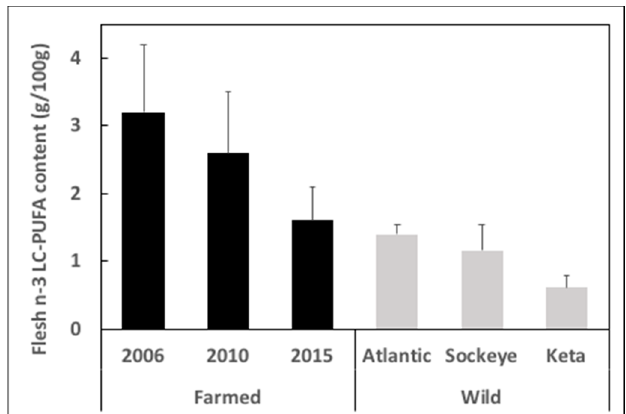
Figure 2. Content of n-3 long-chain polyunsaturated fatty acids (LC-PUFA) in flesh of Scottish farmed Atlantic salmon ( Salmo salar ) in 2006, 2010 and 2015, and in wild Atlantic and Pacific (Sockeye, Oncorhynchus nerka and Keta, Oncorhynchus keta ) salmon. Data are presented as g n-3 LC-PUFA per 100 g flesh and are means ± SD and are taken from Sprague et al. [31,33,34].